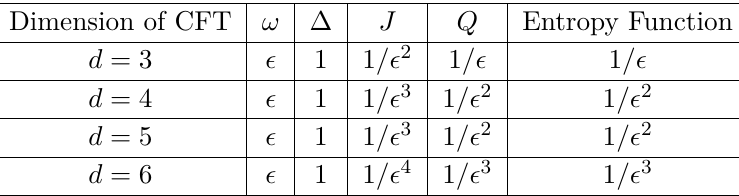
Table 1 . Scaling of conserved quantum numbers in various field theory